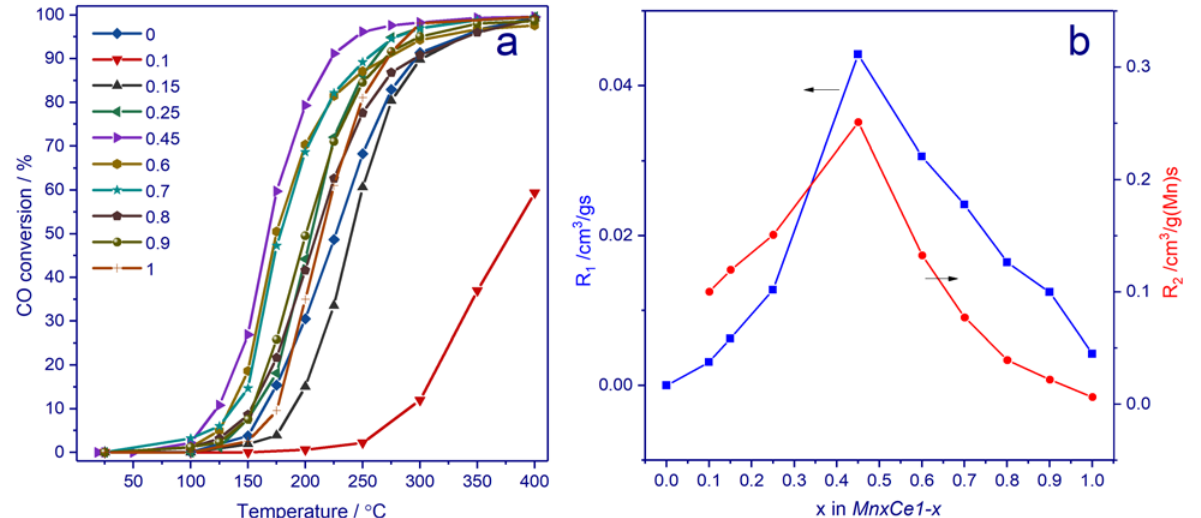
Figure 9. CO oxidation conversion ( a ) and CO oxidation rate at 150 °C normalized per gram (R1, blue dots) and Mn content (R2, red dots) ( b ) for MnxCe1-x catalysts.